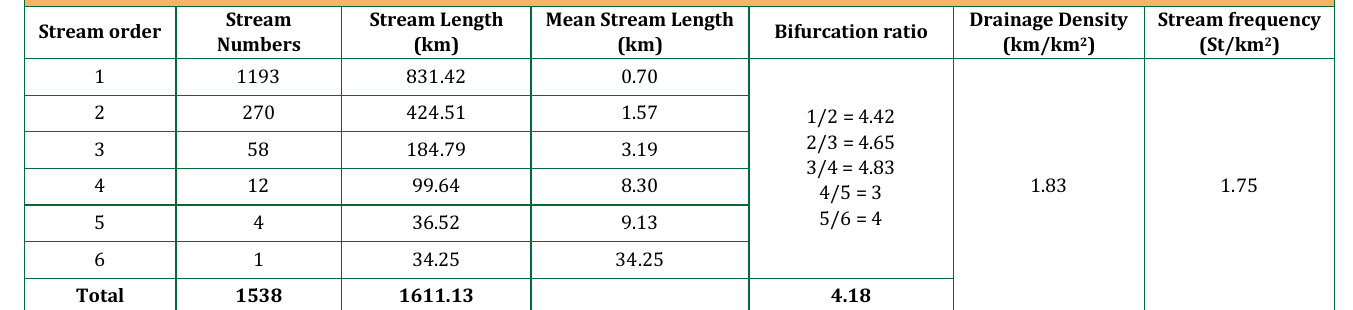
Table 4: Stream network properties of Abbasan watershed